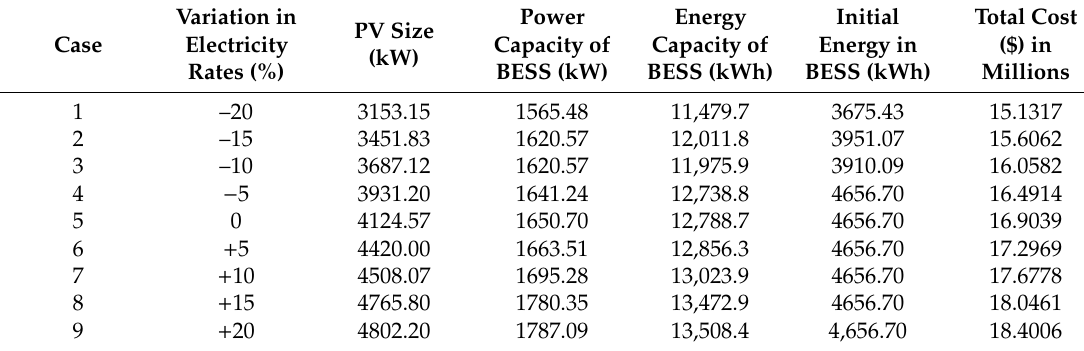
Table 8. Optimal PV system sizing and BESS capacities for varying electricity rates.